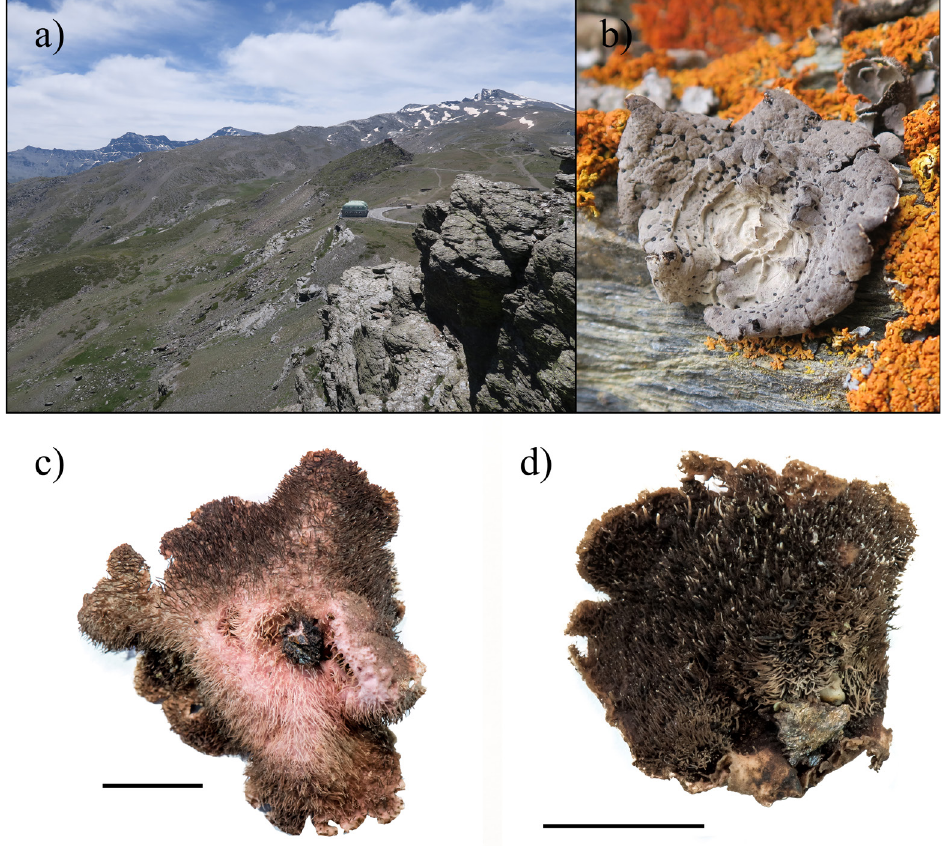
Figure 1. Study area: a, view of Pico Veleta from Los Peñones de San Francisco; b, habitus of Umbilicaria virginis ; c, lower surface of Umbilicaria virginis ; d, lower surface of U. aprina . Bar = 1 cm. In the northern hemisphere the distribution of